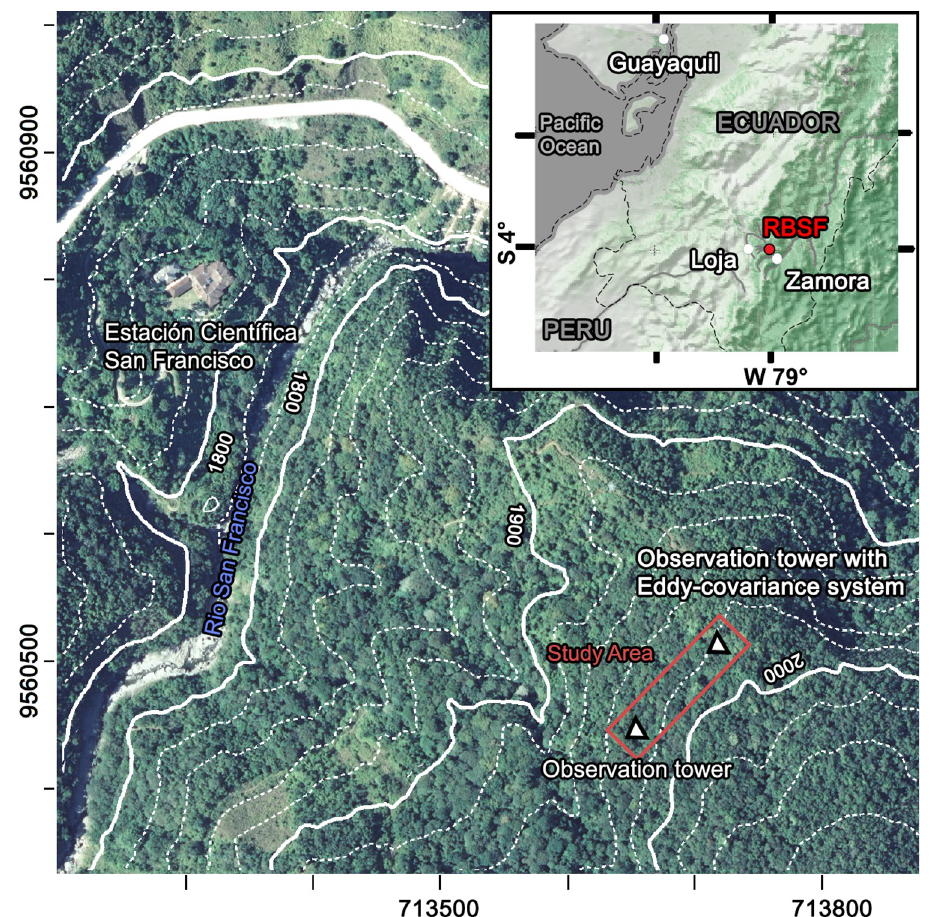
Fig 1. Location of the study region in southern Ecuador (top right) and of the study area in the valley of the San Francisco river (Reserva Biolo´gica San Francisco, RBSF) with the research station Estacio´n Cientifica San Francisco (ECSF) and the position of the core research area between two canopy towers. The Ministerio de Agricultura, Ganaderı´a, Acuacultura y Pesca—Ecuador has kindly provided the SIGTIERRAS (Sistema Nacional de Informacio´n y Gestio´n de Tierras Rurales e Infraestructura Tecnolo´gica) orthophoto, which is the basis of the